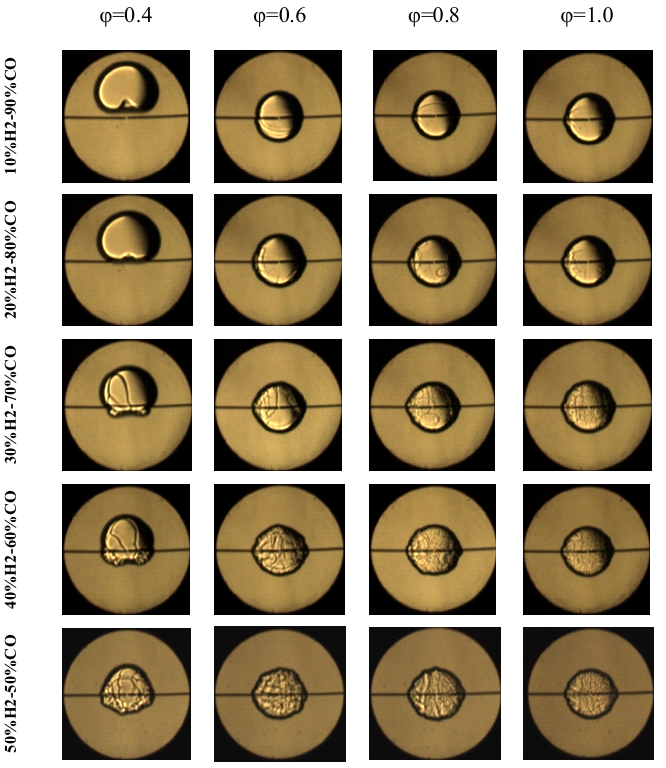
Figure 4. Schlieren pictures for flames with hydrogen fractions from 10% to 50% at 0.3 MPa at different equivalence ratios for 20 mm radius.